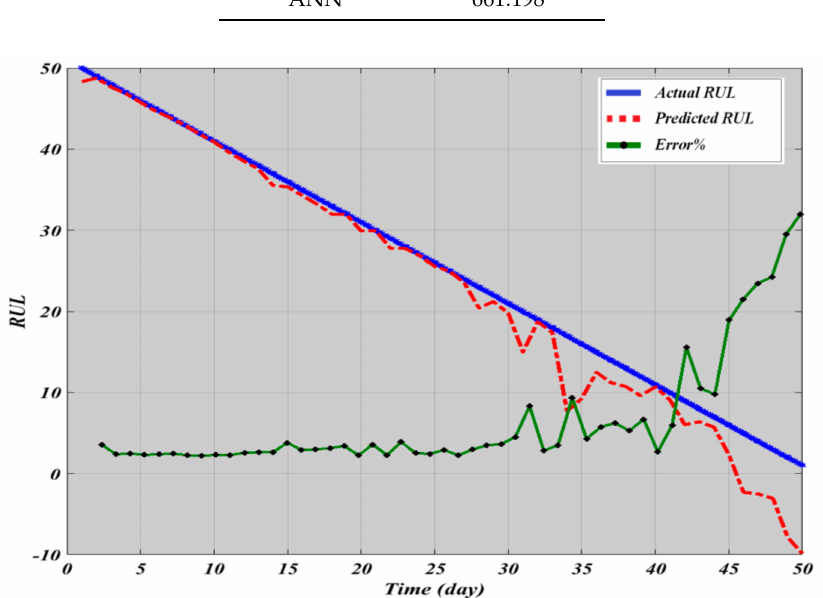
Figure 10. Regression Model RUL